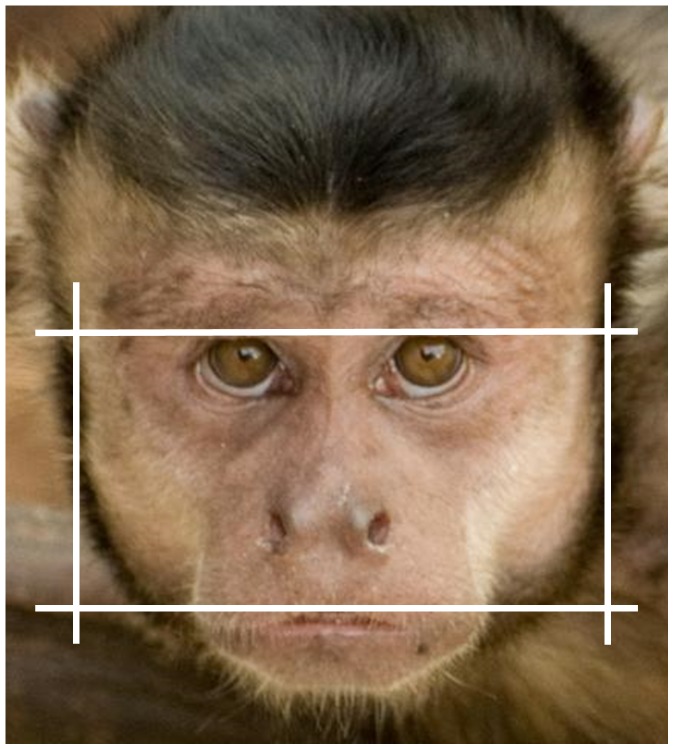
Illustration of the facial width-to-height ratio: zygomatic width (distance between vertical lines) divided by upper face height (distance between horizontal lines).